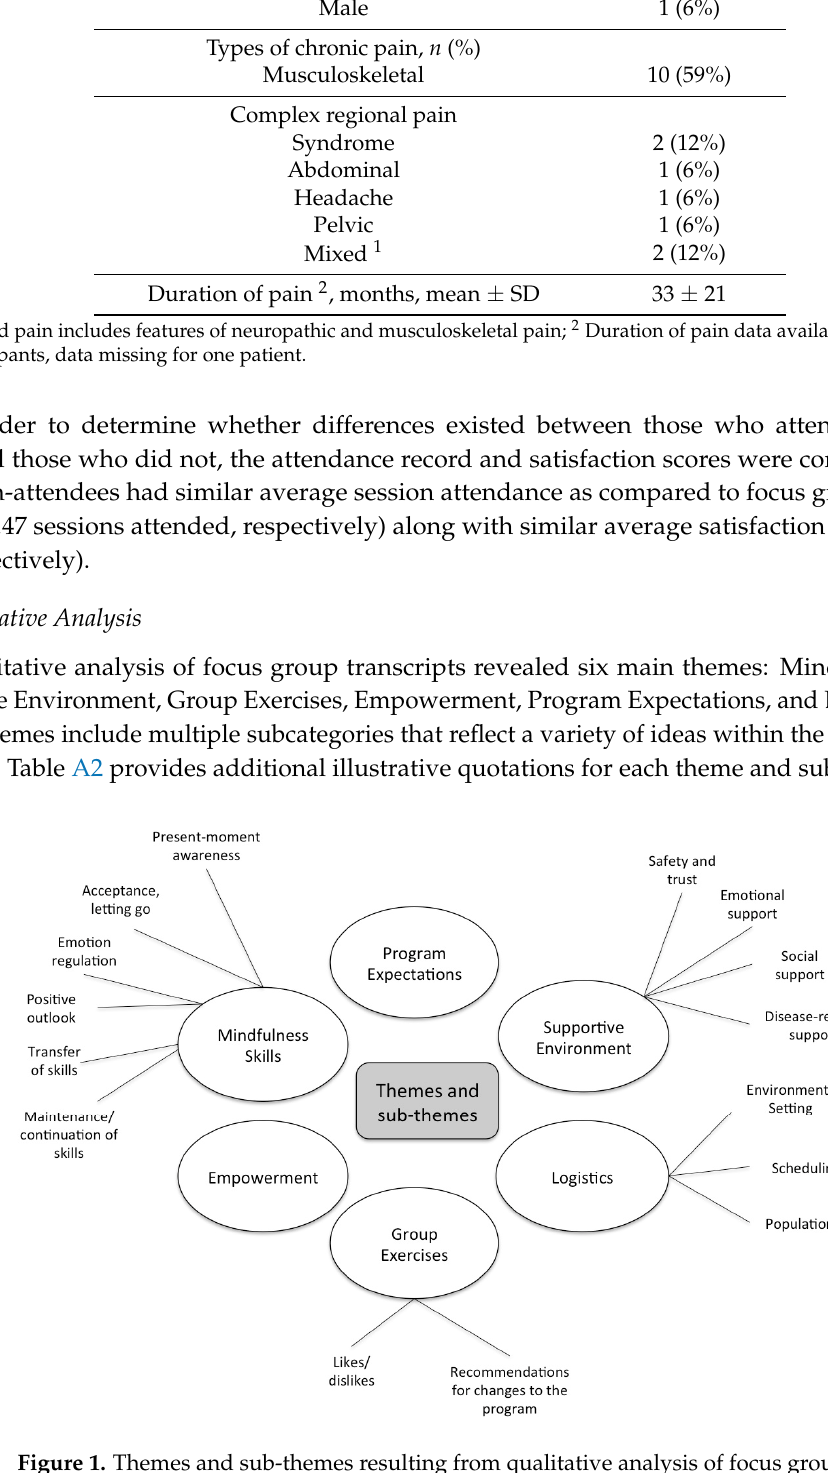
Figure 1. Themes and sub-themes resulting from qualitative analysis of focus groups.